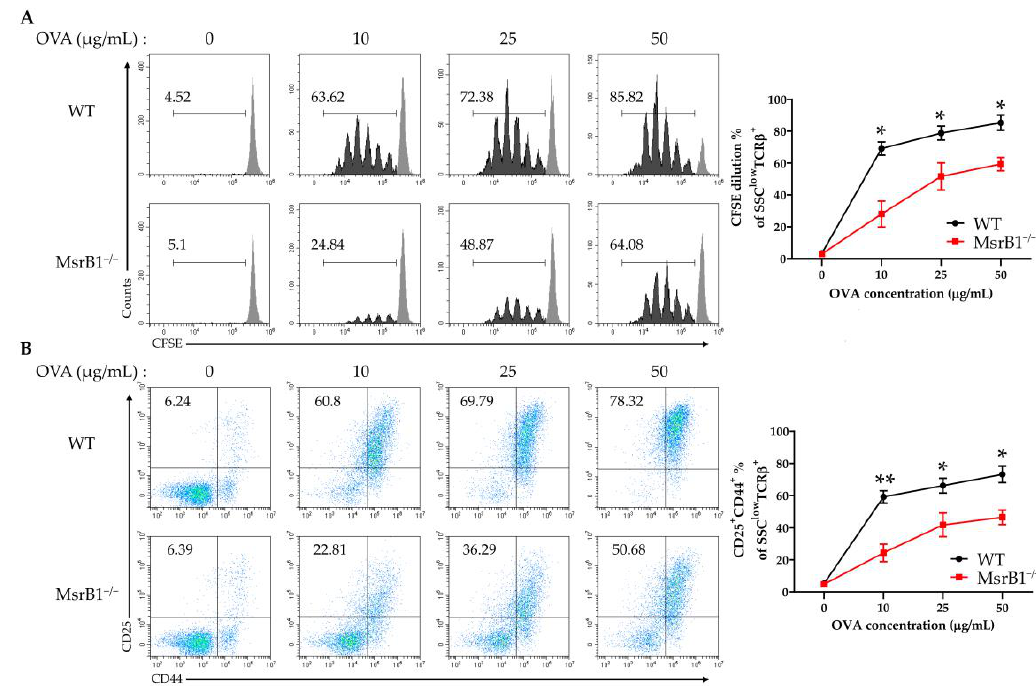
Figure 2. MsrB1 is needed for the ability of DCs to induce CD4 T-cell proliferation and activation. carboxyfluorescein succinimidyl ester (CFSE)-stained OT-II cells were cocultured for 3 days with WT and MsrB1 −/− BMDCs that had been loaded with 0, 10, 25, or 50 μg /mL ovalbumin (OVA) ( n = 3 per group). The CFSE dilution ( A ) and CD25 and CD44 expression ( B ) of the OT-II cells were measured by flow cytometry with gating on the side scatter (SSC) low T cell-receptor (TCR)- β + cells in the live cells. Mean ± SEM are shown. * p < 0.05, ** p < 0.01; ns, not significant, as determined by unpaired t- test. The data are representative of two independent experiments, both of which had similar results.